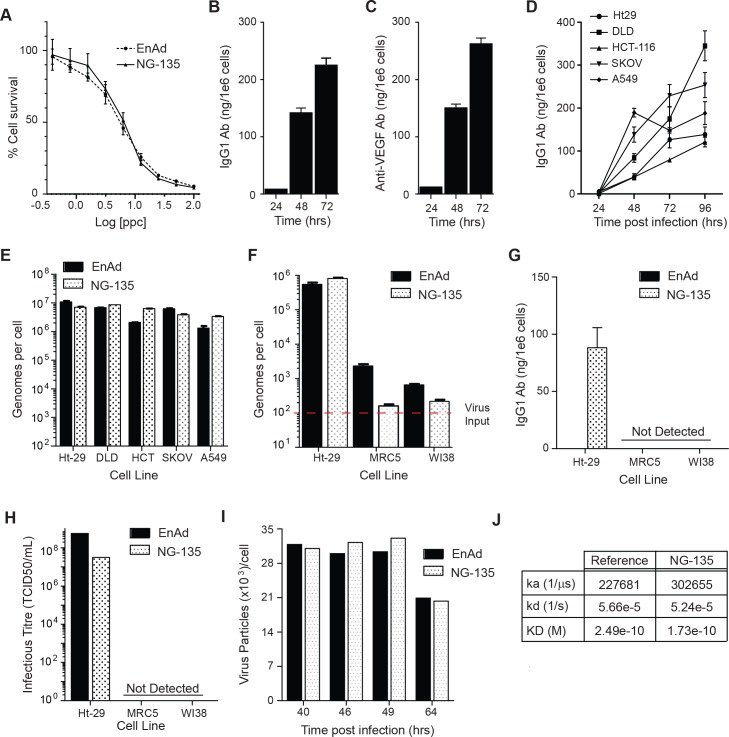
Characterisation of virus activity and functional expression of monoclonal antibodies.(A) HT-29 cells infected with NG-135 or enadenotucirev virus particles over a range of 100–0.39 ppc for 72hrs then assessed for cell viability. Graph shows quantification of % cell survival relative to uninfected controls. (B) IgG1 antibody expression detected in cellular supernatants of HT-29 cells infected with 10ppc NG-135 by anti-IgG1 ELISA. (C) Quantification of VEGF-165 binding of antibody expressed in cellular supernatants described in (B). (D) IgG1 antibody expression, assessed by anti-IgG1 ELISA, in cellular supernatants of carcinoma cell lines infected for 24-96hrs with NG-135 at 1ppc. (E) Viral genomes (quantified by qPCR) in the supernatants of carcinoma cells infected for 96hrs with 1ppc of enadenotucirev or NG-135. (F) Viral genomes (quantified by qPCR) in the supernatants of HT-29 or fibroblast cell lines infected for 72hrs with 100ppc of NG-135 or enadenotucirev. (G) IgG1 antibody expression detected in cellular supernatants described in (F). (H) Infectious virus particle titre assess by TCID50 using cellular supernatants described in (F). (I) Total virus particle yield per cell (quantified by HPLC) in the cellular and supernatant culture fractions of HEK293 cells infected for up to 64hrs with NG-135 or enadenotucirev at 50ppc. (J) Table showing results obtained from Biacore analysis of VEGF-165 binding for antibody purified from NG-135 infected HEK293 cells compared to the bevacizumab reference standard. The data shows the equilibrium dissociation constant between the antibody and the VEGF antigen (KD), calculated from the rates of antibody to antigen association (Ka) and dissociation (kd). Unless otherwise stated all graph data points are plotted as mean ± SD (n = 3 experimental replicates).